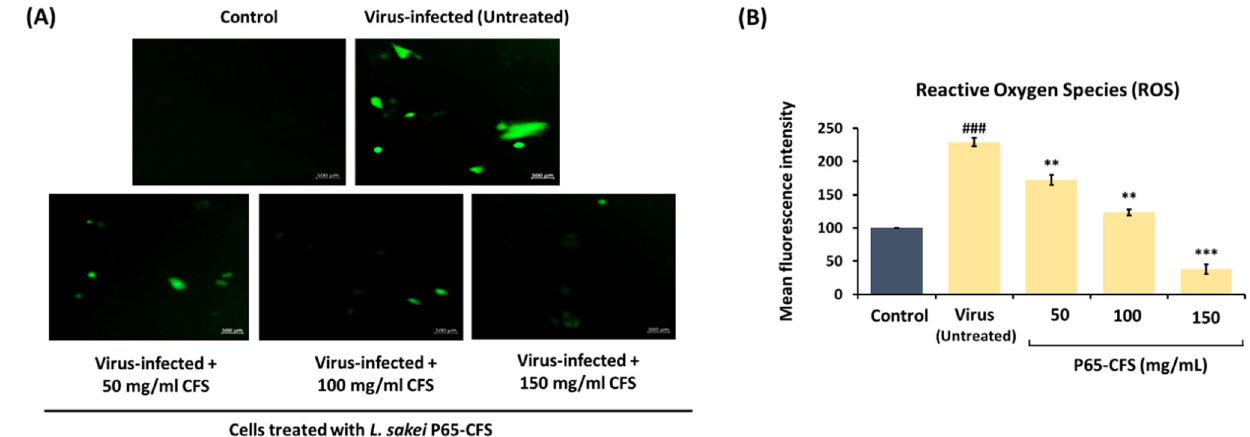
Figure 3. Accumulation of cellular reactive oxygen species (ROS) in HEK 293 cells upon infection with SARS ‐ CoV ‐ 2. ( A ) Representative fluorescence images of ROS staining with the fluorogenic dye dichlorofluorescein (H2DC FDA), and ( B ) intensity quantitation by image J. At the end of the treatment, SARS ‐ CoV ‐ 2 ‐ infected cells were stained with H2DCFDA for 30 min, washed with PBS, and imaged under a confocal microscope (scale is 500 μ m). Analysis of each sample was performed in triplicate, and data are represented as the means ± SD of three independent experiments. Independent T ‐ tests were performed to compare the data with the controls, where (###) represents p < 0.001 as compared to the control; (***) represents p < 0.001, (**) represents p < 0.01 and (*) represents p < 0.05 as compared to the virus (infected, untreated negative control).